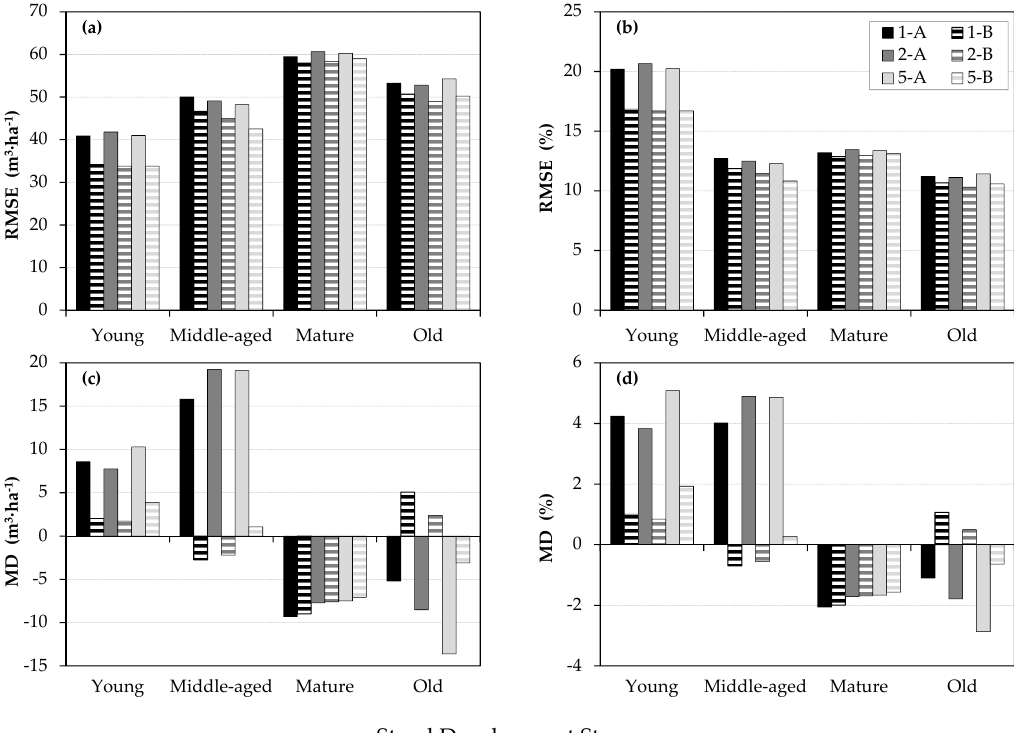
Figure 4. Validation results by stand development stages (young, middle-aged, mature, old): ( a ) root mean square error (RMSE); ( b ) relative root mean square error (RMSE % ); ( c ) mean difference (MD); and ( d ) relative mean difference (MD % ).